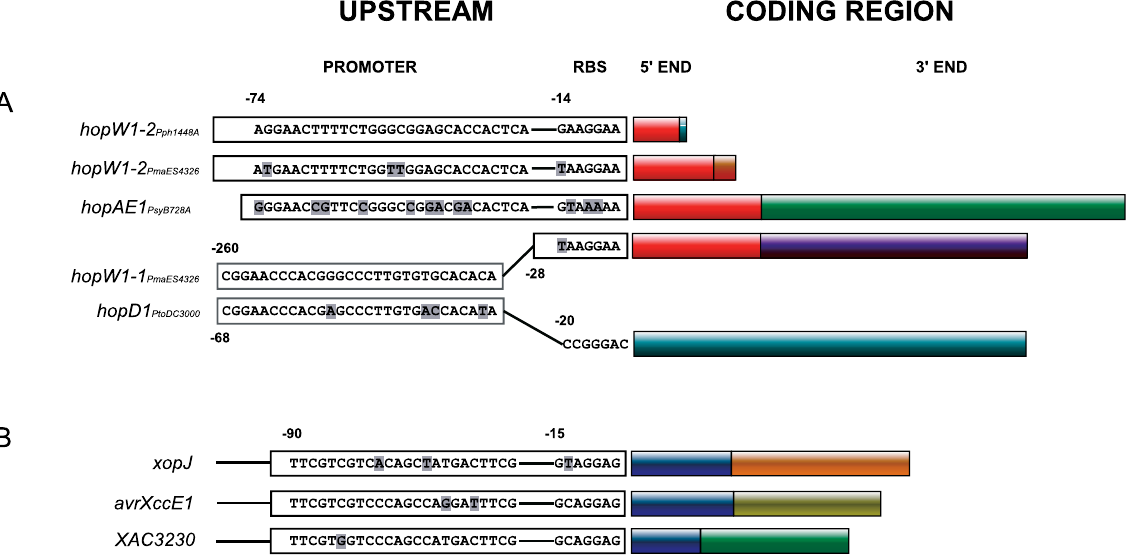
Figure 2. Genetic Organization of ORPHETs and Chimeras Illustrating Conserved Regulatory and Protein-Coding Regions Homologous gene regions within each panel share the same coloring. The coding region of each T3SE starts at the beginning of the solid black bar, although the length of the upstream region is not to scale with the coding region. The promoter sequences and ribosome-binding sites are indicated, but not shown to scale. Variable residues in these sequences have been highlighted in gray. (A) The three HopW1 family members along with HopAE1 PsyB278a in P. syringae share N-terminal homology that extends to the upstream region and includes the ribosome-binding site and hrp box promoter. The hrp box promoter of HopW1–1 PmaES4326 and flanking region, however, is more closely related to that of HopD1 PtoDC3000 , although these two proteins are not homologous. (B) Xanthomonas spp. effectors XopJ and AvrXccE1 along with hypothetical protein XAC3230 share a common N terminus and display conservation upstream of the protein-coding region.